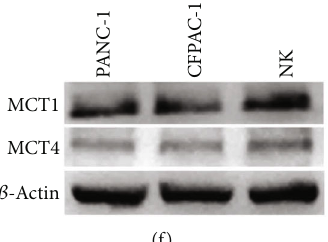
Figure 5: LDHA expression in PC. (a, b) IHC scores of LDHA expression in 100 pairs of PC tissues and adjacent tissues. (c) Representative IHC images of LDHA expression in PC tissues and adjacent tissues. (d) According to IHC, LDHA expression in PC tissues was signi fi cantly higher than that in corresponding adjacent tissues. (e) Kaplan – Meier curves comparing the OS of patients grouped by LDHA expression. (f) MCT1 and MCT4 expression levels in PANC-1, CFPAC-1, and NK cells were measured by western blotting, and β -actin served as the internal control. The data are presented as the mean ± SD from three independent experiments. ∗ P ≤ 0 : 05 , ∗∗ P ≤ 0 : 01 , and ∗∗∗ P ≤ 0 : 001